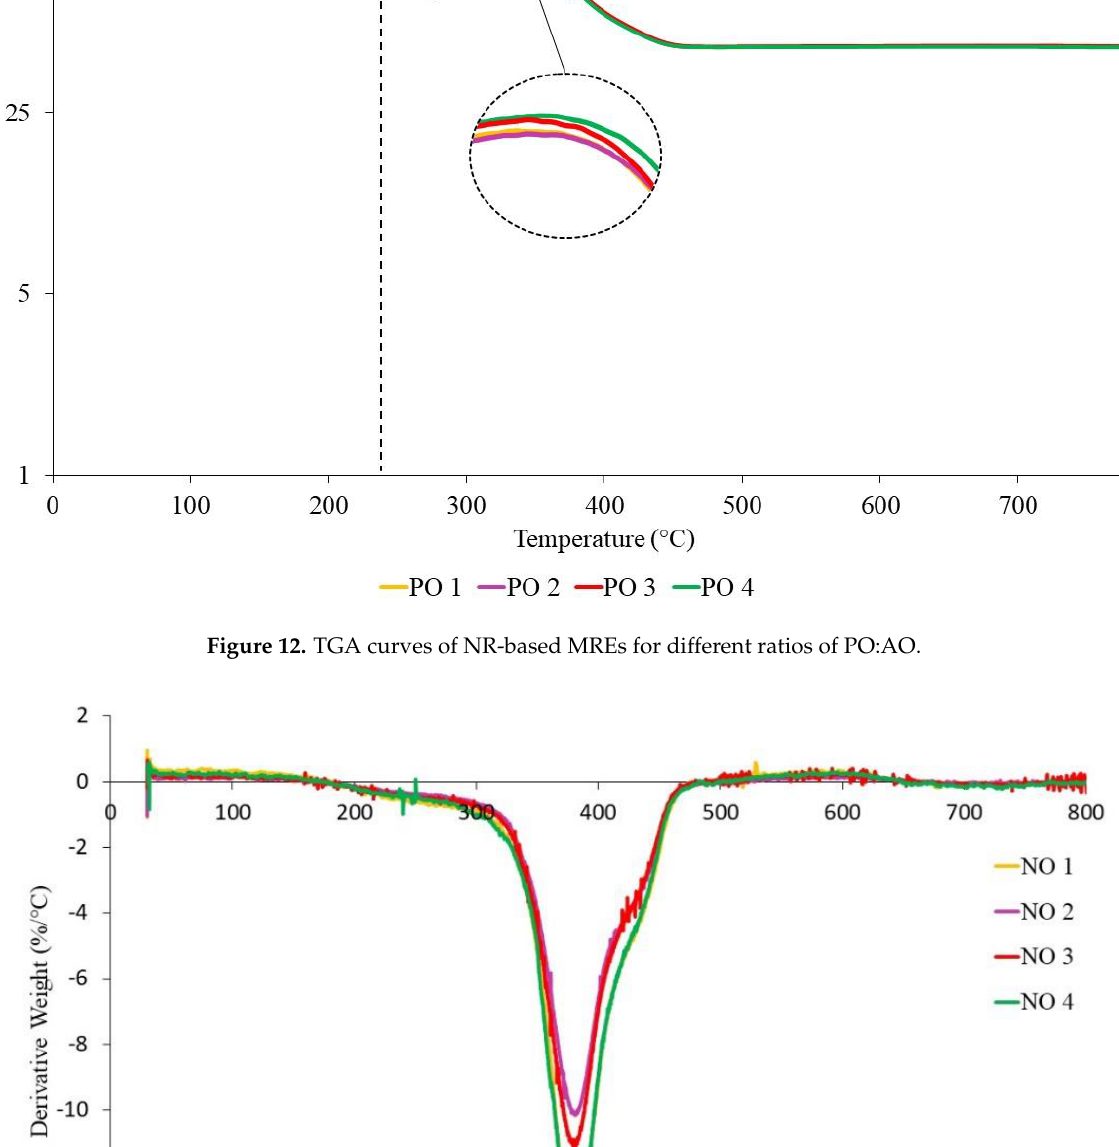
Figure 14. DTG curves of NR-based MREs for different ratios of LMO:AO.